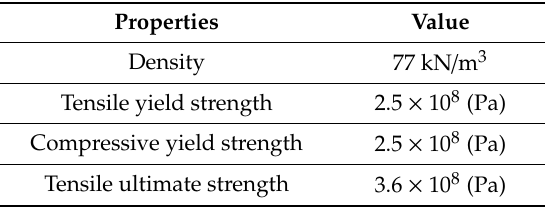
Table 1. The properties of structural steel.